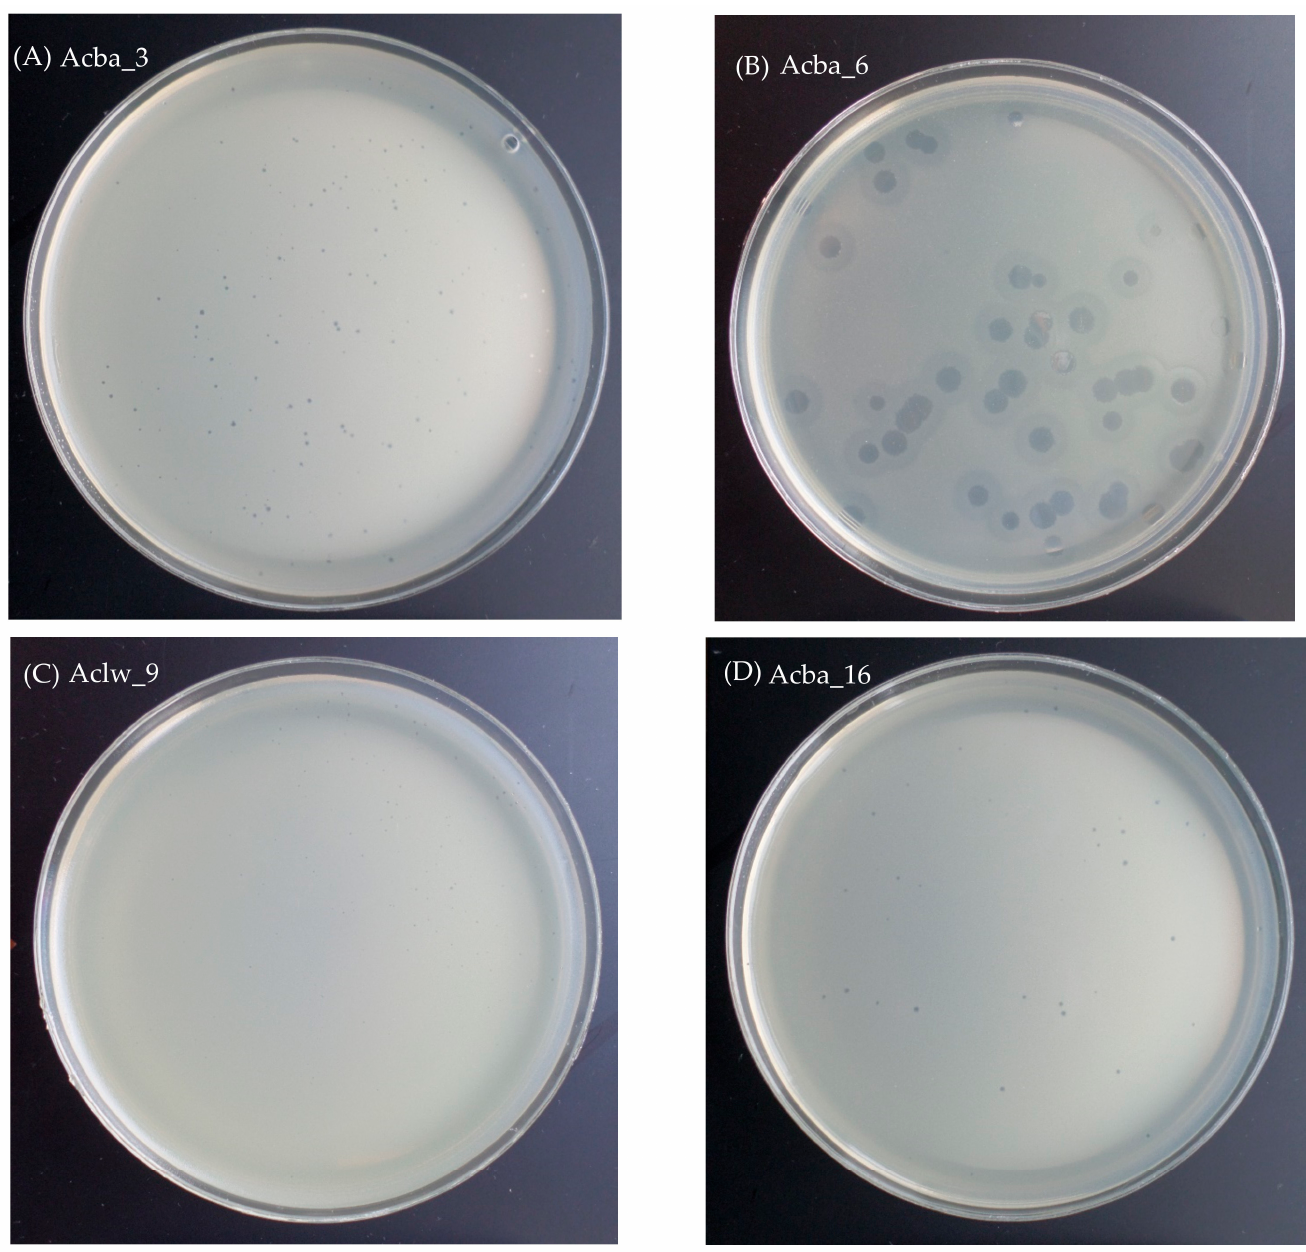
Figure 1. Pictures showing the morphology of plaques of selected phages. Panel ( A ): Acba_3, Panel ( B ): Acba_6, Panel ( C ): Aclw_9, Panel ( D ): Acba_16. Small, transparent plaques (Acba_3, Aclw_9, Acba_16) and larger plaques with a ‘halo’ effect (Acba_6) are visible on the plates. Photos of phage plaques were taken with the Samsung ST150F camera.